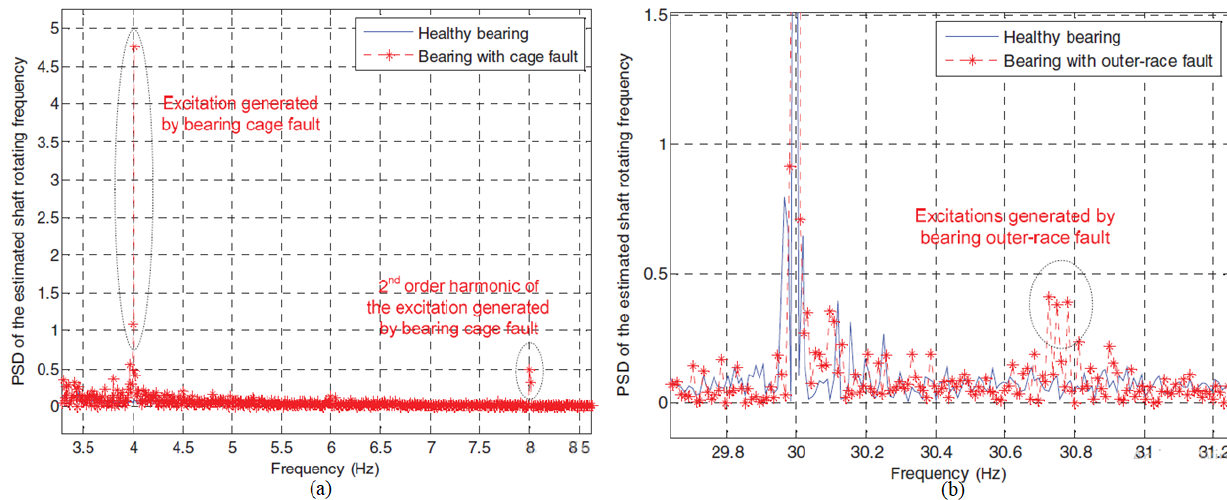
Figure 11. Power spectral density (PSD) results for the diagnosis of bearing fault in the wind turbine for ( a ) bearing cage fault and ( b ) outer race fault. Reproduced with permission of [30].